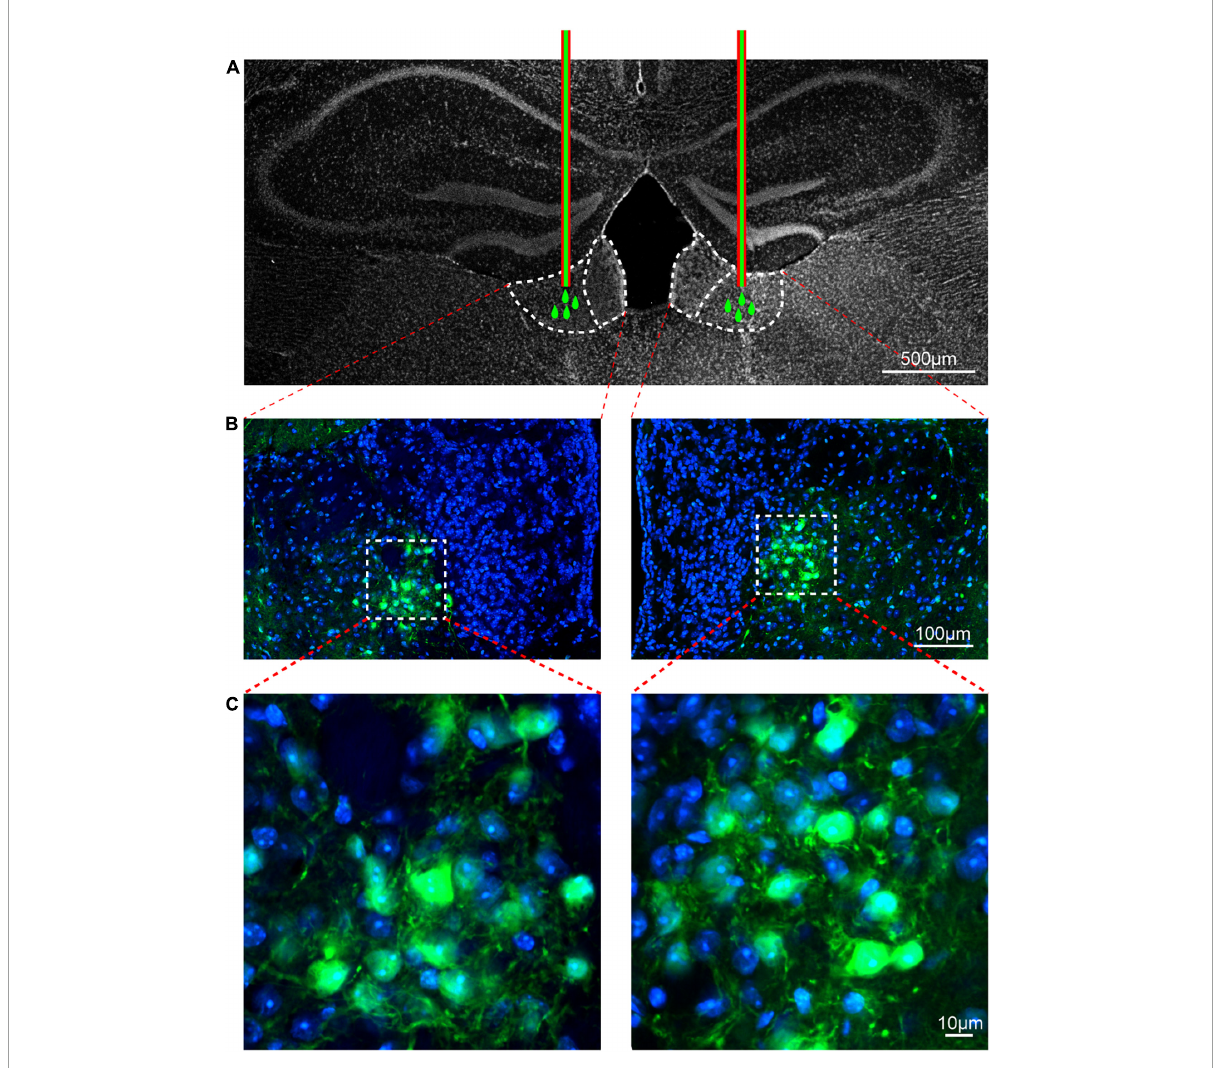
FIGURE7 Viral transfection was mainly localized in the lateral habenula. The injection locations of pAOV-CaMKII-HM3D(Gq)-EGFP-3FLAG virus (A) . The virus transfection position in the LHb was shown by the typical immunofluorescence staining; Green, EGFP; Blue, DAPI [ B,C (Zoom)]. Scale bar: 500 µ m (A) , 100 µ m (B) and 10 µ m (C)